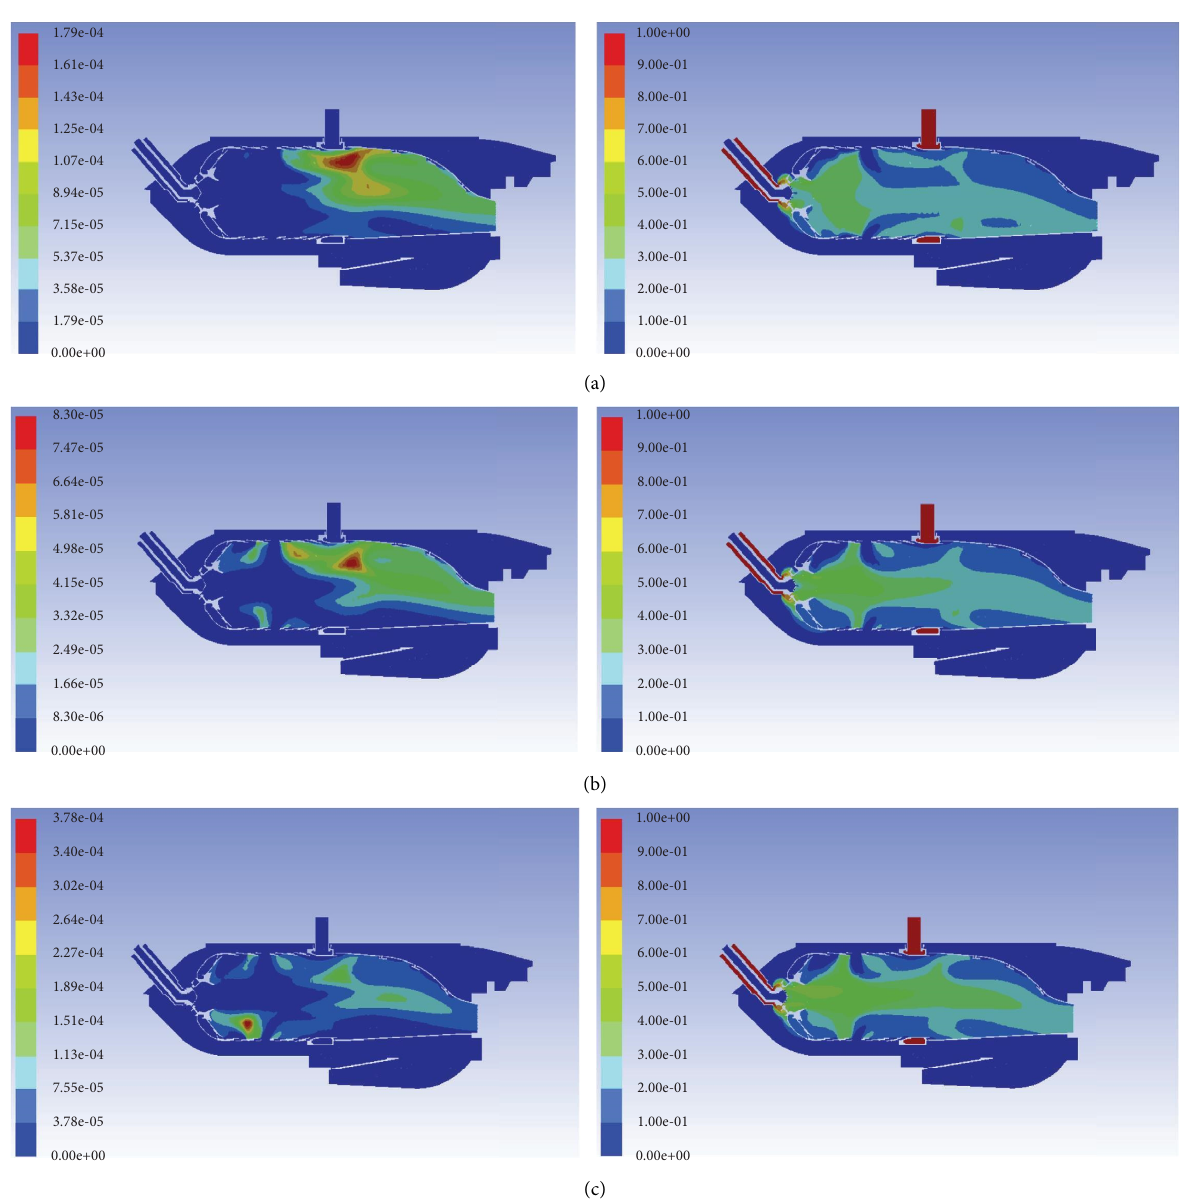
Figure 9: Contours of mass fraction of NO and H 2 O inside the combustion chamber for diferent volume content of hydrogen in the mixture: 0% (a), 50% (b), 100%